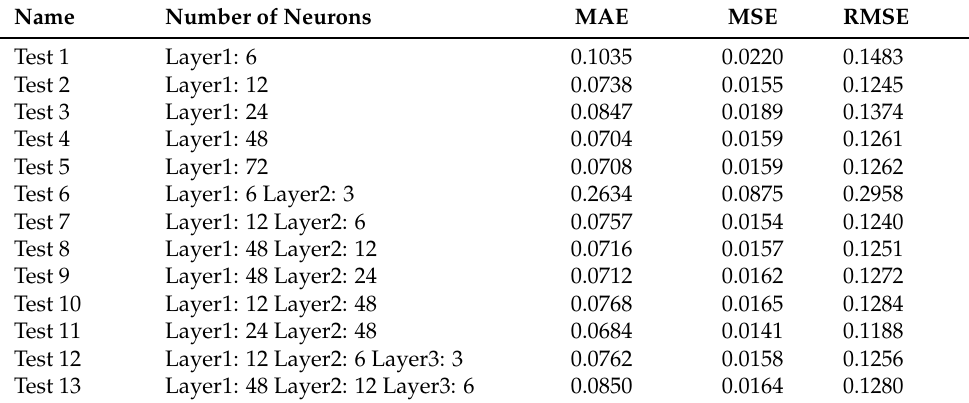
Table 4. Adam algorithm test results.